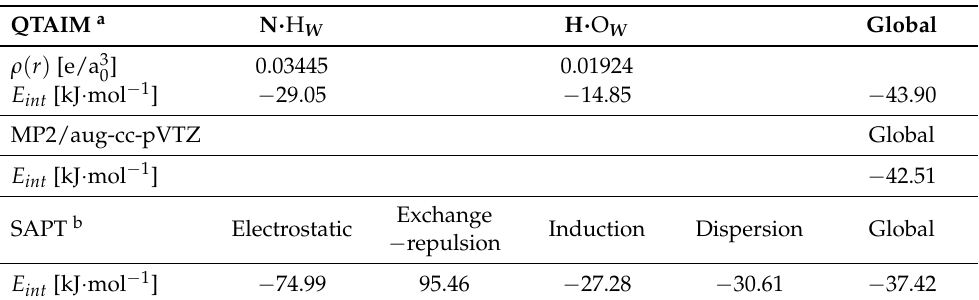
Table 5. Intermolecular BCP’s electron density and interaction energy values of DEHA-W. QTAIM a N · H W Global